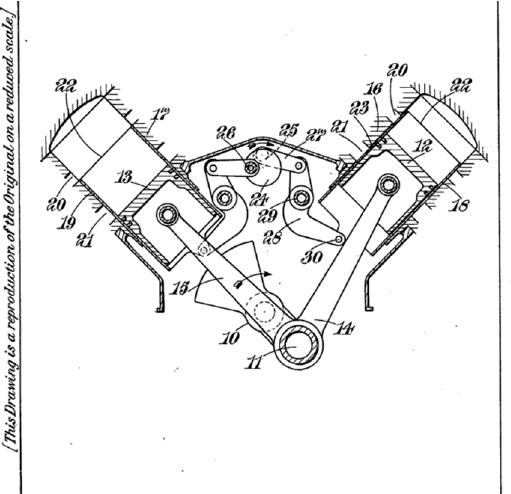
Figure 11. A.J. Rowledge Rolls-Royce 2 February 1939: two-stroke sleeve drive of V engine-configuration engines GB 524642A. Reproduced with permission from GB Patent Office Copyright Publisher, 1934.